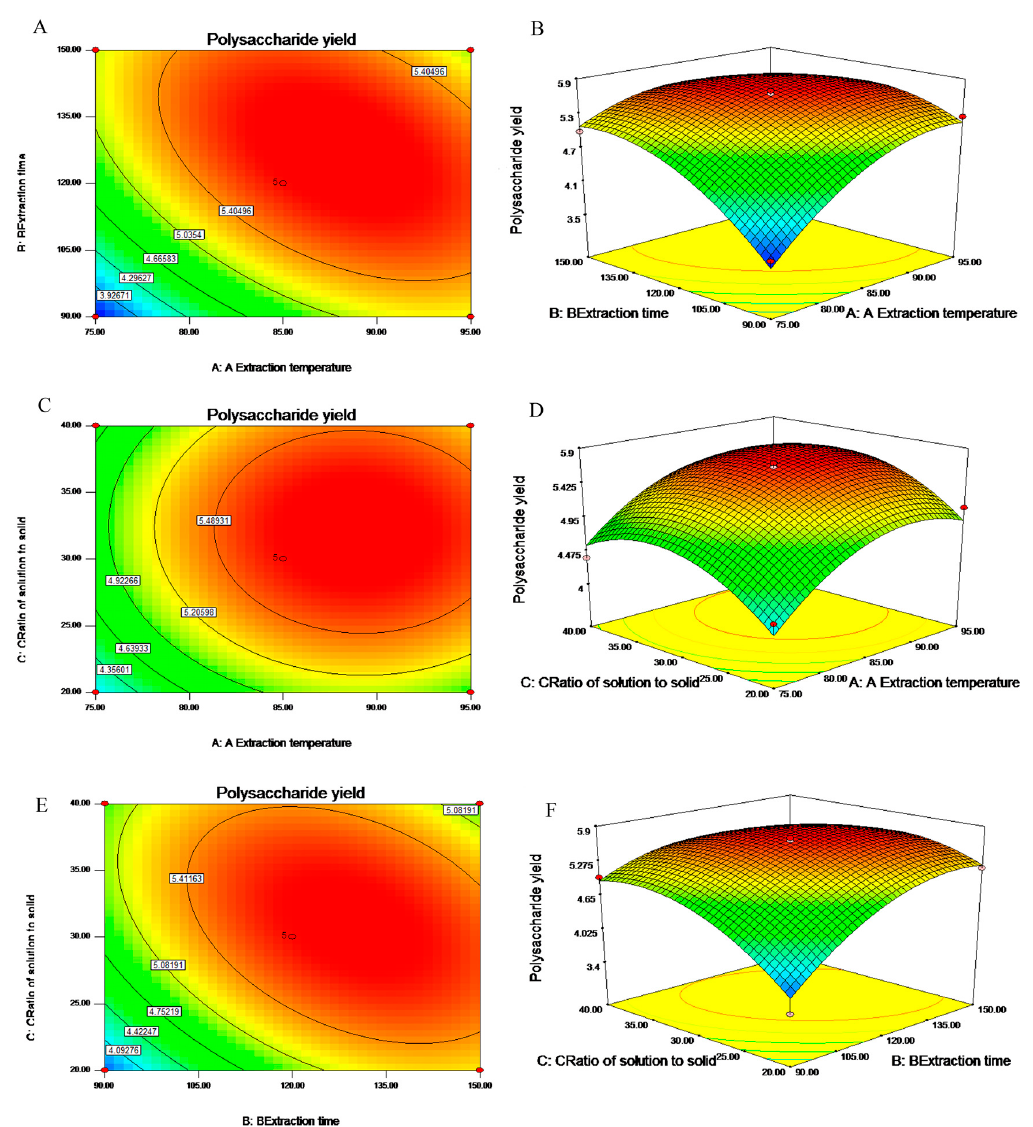
Figure 1. Response surface ( left ) and contour ( right ) plots of the effects of 3 variables, extraction temperature ( X 1 ), extraction time ( X 2 ) and ratio of solution to solid ( X 3 ) on the yield of SJP extraction: ( A ) response surface showing the effect of extraction temperature and extraction time on the yield of SJP extraction; ( B ) contour plot showing the effect of extraction temperature and extraction time on the yield of SJP extraction; ( C ) response surface showing the effect of extraction temperature and ratio of solution to solid on the yield of SJP extraction; ( D ) contour plot showing the effect of extraction temperature and ratio of solution to solid on the yield of SJP extraction; ( E ) response surface showing the effect of extraction time and ratio of solution to solid on the yield of SJP extraction; ( F ) contour plot showing the effect of extraction time and ratio of solution to solid on the yield of SJP extraction.